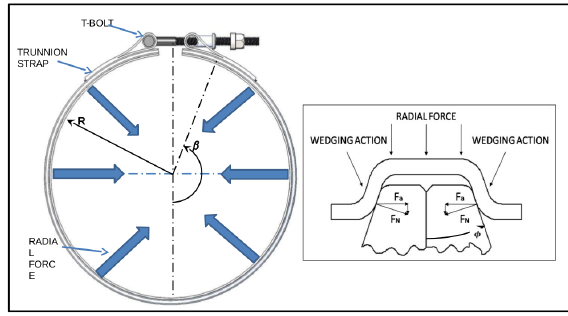
Figure 2: Working principle of V-band clamp assembled to a pair of